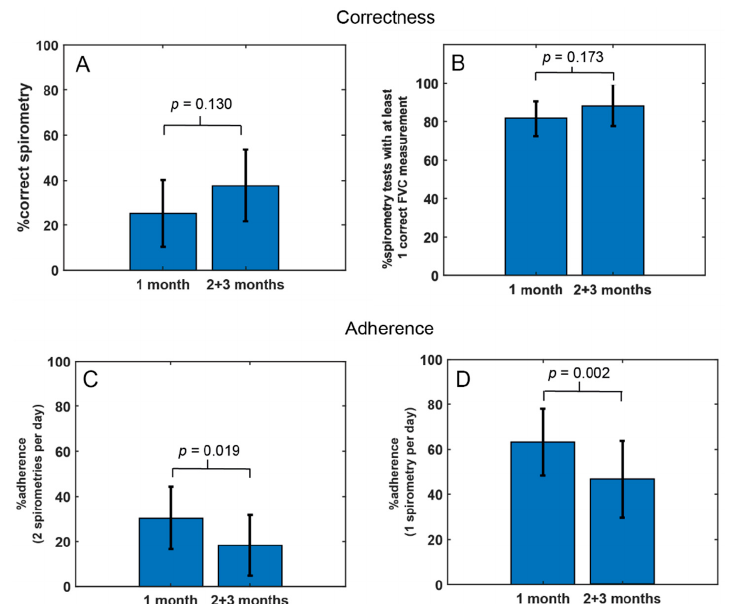
Figure 1. Compliance analysis of pulmonary function telemonitoring. Correctness: ( A ) percentage of the correct examinations (ATS/ERS 2019) [31]; ( B ) percentage of the exams with at least one corrected measurement. Adherence: ( C ) percentage of the days with at least two examinations/total number of the days (30 or 60 days) × 100%); ( D ) percentage of the days with at least one measurement/total number of the days (30 or 60 days) × 100%).